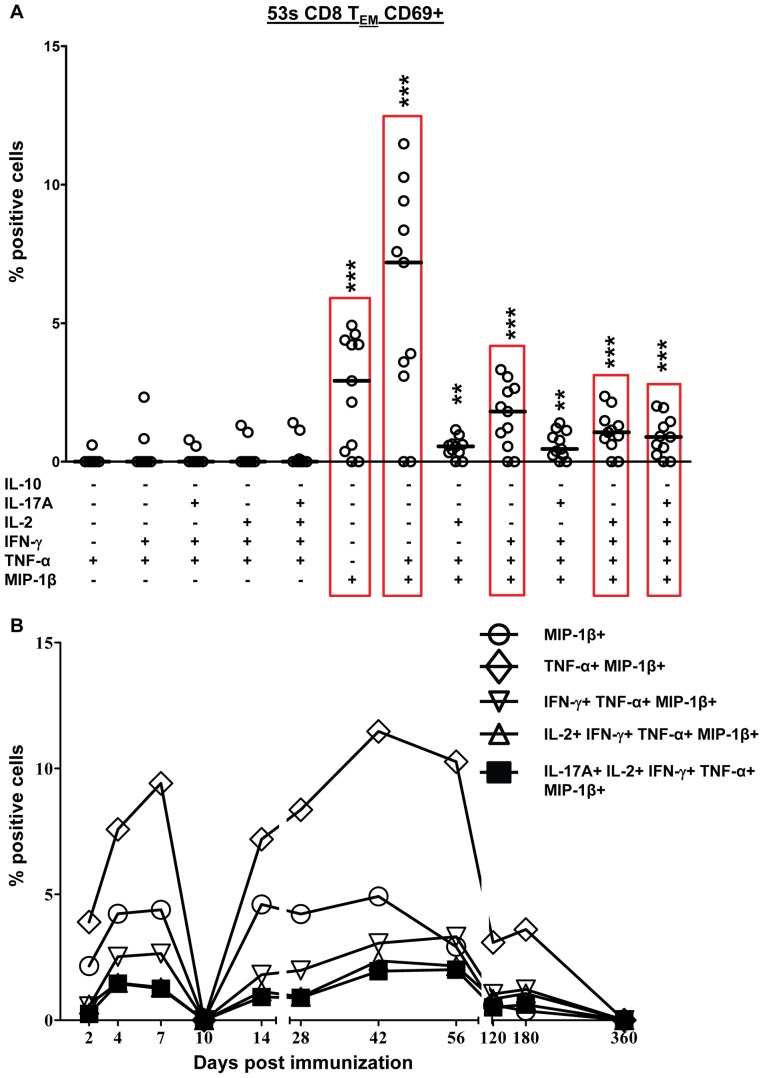
Multifunctional CD8+ TEM responses to S. Typhi-infected HLA-E restricted cells.A) Scatter plot showing all combinations of the 6 cytokines/chemokines measured that were positive at one or more time points for representative volunteer 53 s. Increases of >0.5% positive cells over uninfected targets were statistically significant. Each point represents a single time-point and the median value is denoted by a horizontal bar. The cyokine/chemokine combinations with the top 5 median values are indicated by red rectangles. Median values of the subsets of multifunctional cells that show a significant difference (**P<0.01, ***P<0.001), when compared to the subsets without asterisks, are indicated. B) Kinetics of the top 5 populations (as determined by median value) over time.